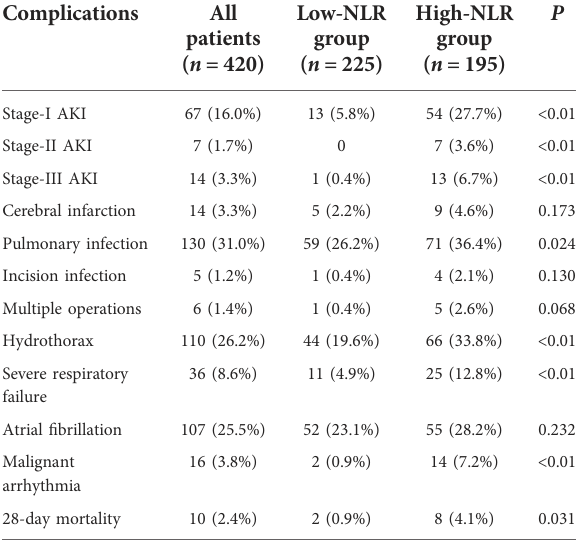
TABLE 5 Correlation between the NLR and postoperative